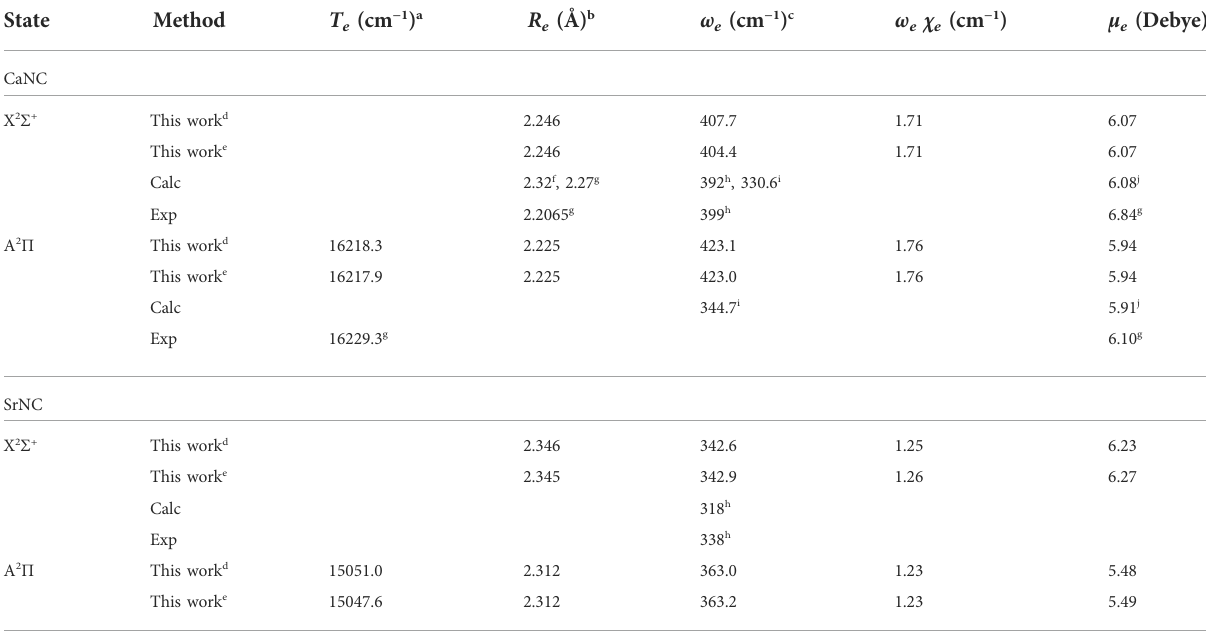
TABLE 1 Spectroscopic constants of the ground state and the fi rst excited state of CaNC and SrNC.